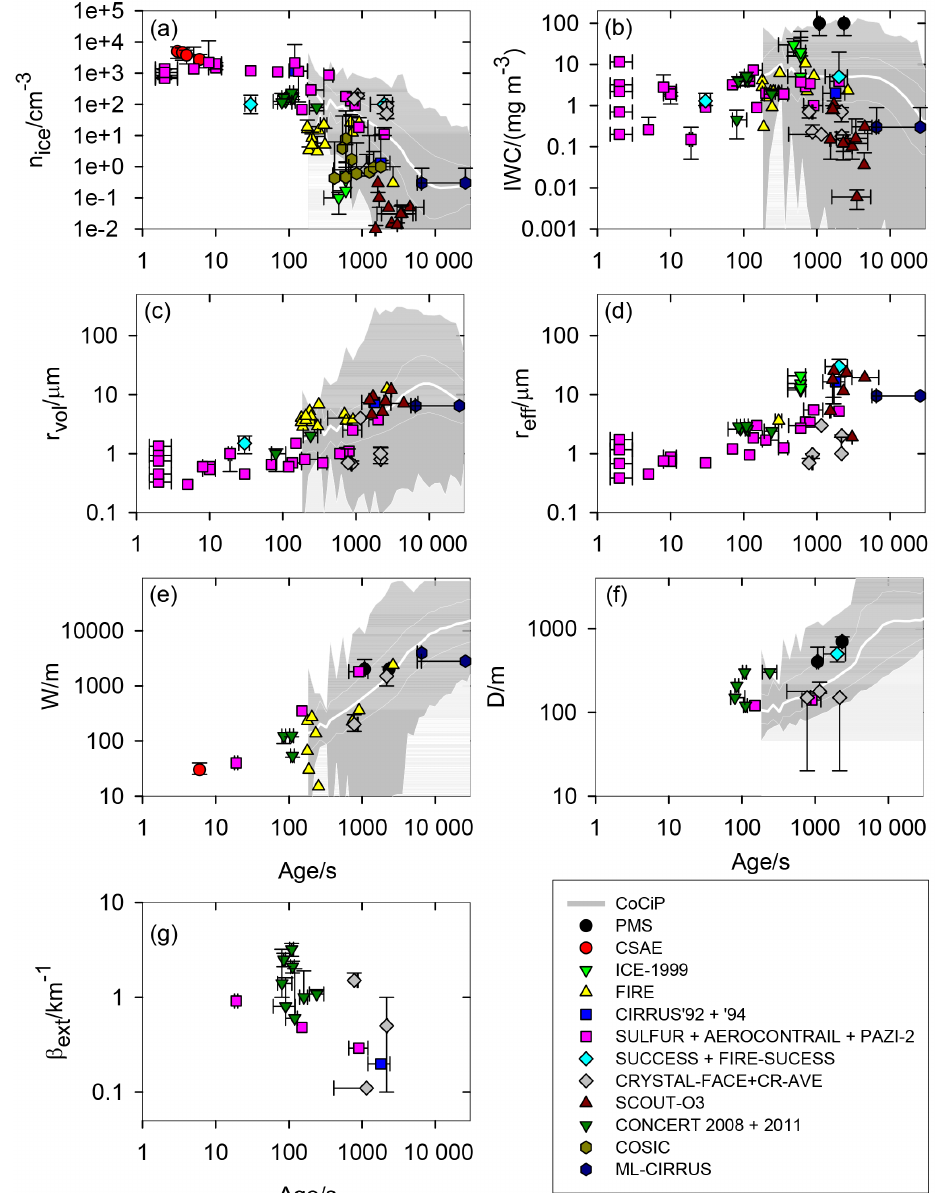
Figure 1. Contrail parameters from in situ observations versus contrail age, together with results from a model simulation (CoCiP). (a) Number concentration of ice particles n ice in cm − 3 , (b) ice water content IWC in mgm − 3 , (c) volume mean radius r vol in µm, (d) effective radius r eff in µm, (e) contrail width W in m, (f) total contrail depth D in m, and (g) optical extinction β ext in km − 1 . The grey-shaded white lines depict mean CoCiP results (0th, 10th, 50th, 90th, and 100th percentiles); the thick white line is the median value (50%). Various symbols denote various observation projects (or group of projects); see Table 7. Error bars, as far as available, indicate estimated ranges of variability during the measurements and reflect uncertainties (e.g., in